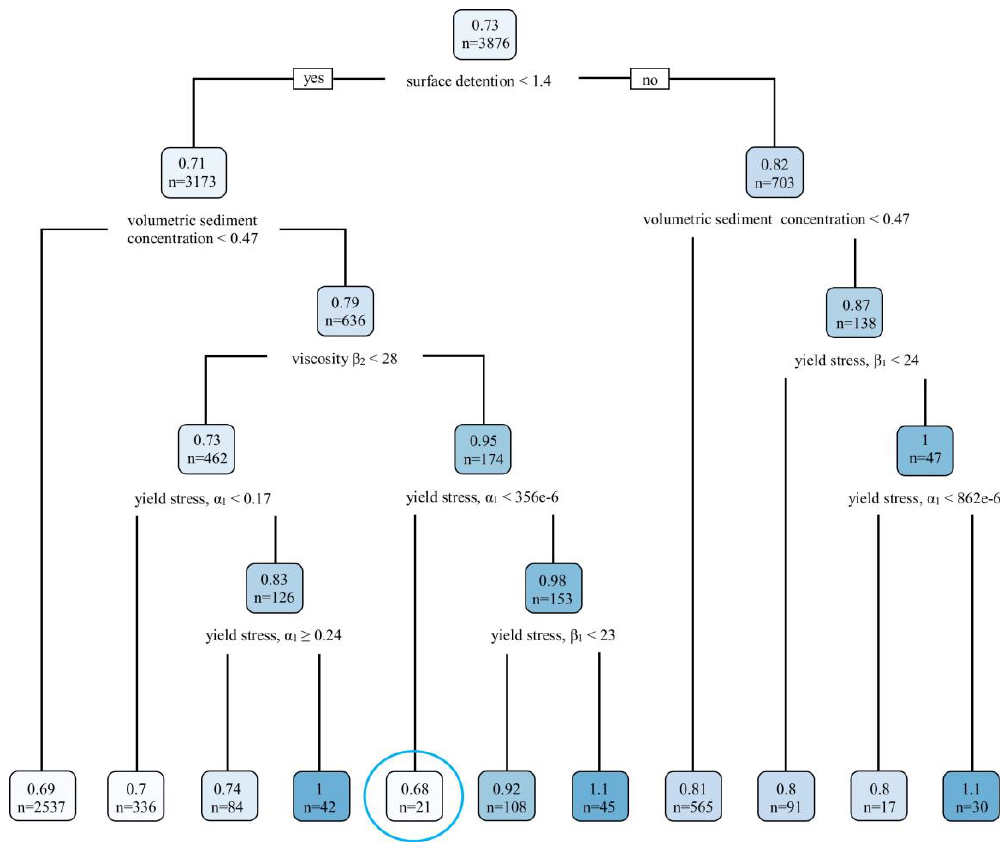
Figure 6. Regression tree based on average gRMSE1 values; minsplit = 0, cp = 0.02.